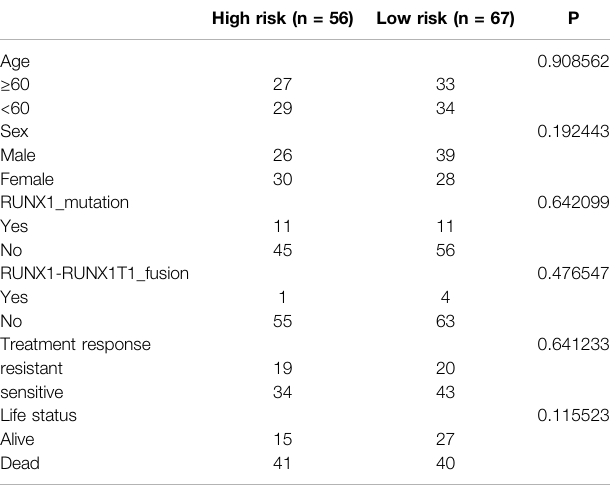
TABLE 2 | Clinical characteristics of patients from GSE106291 included in the validation study. High risk (n = 56) Low risk (n =